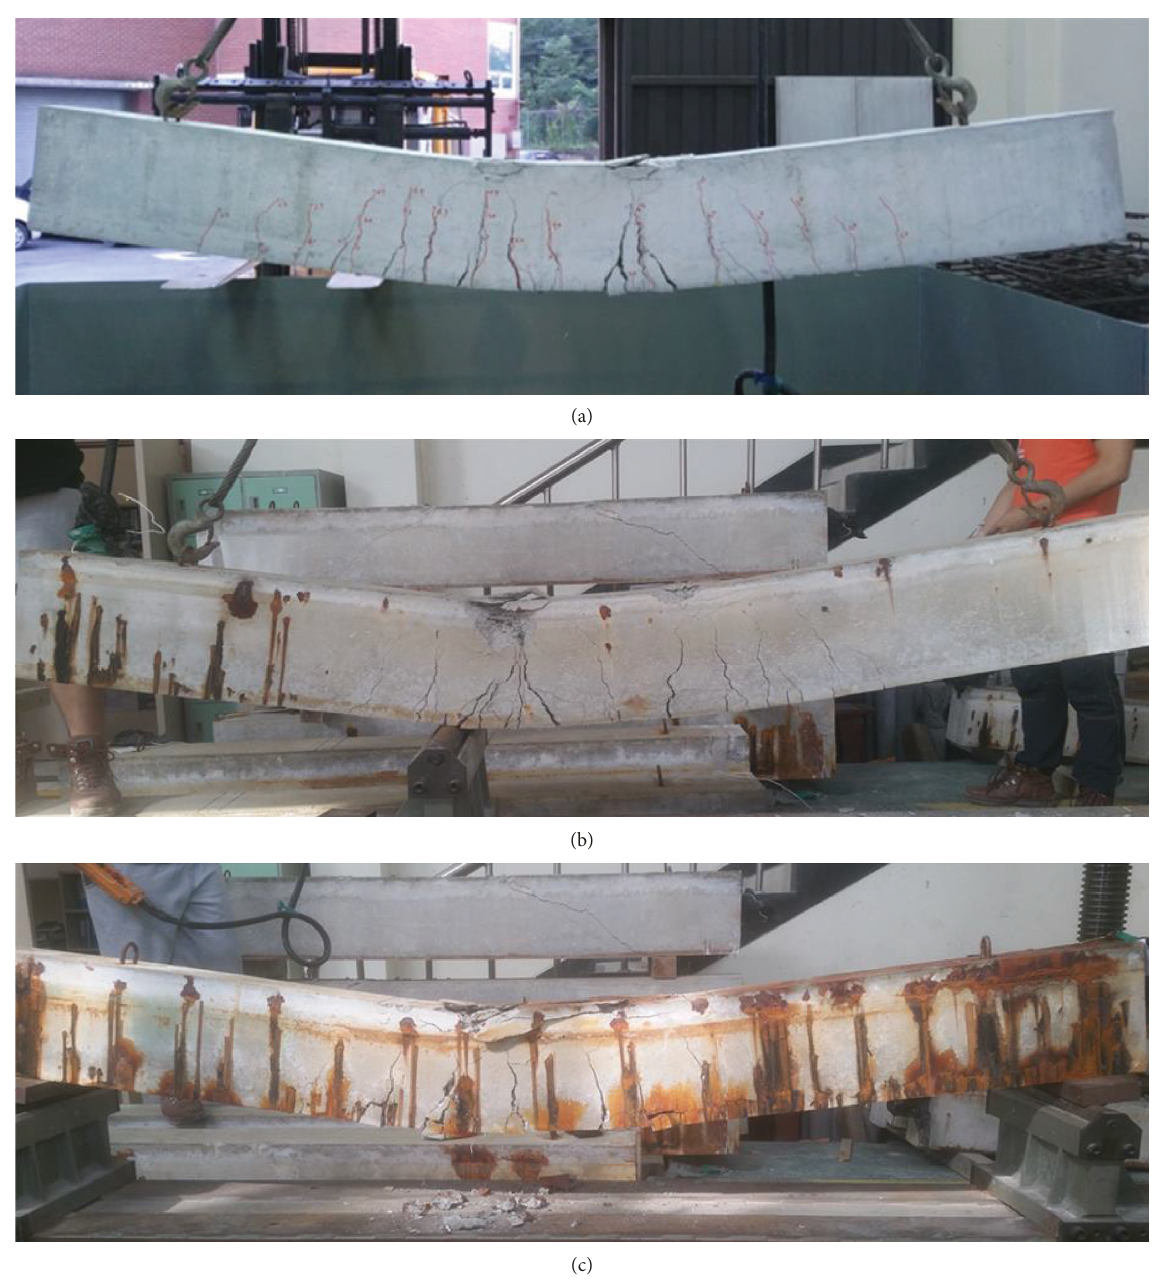
Figure 10: Cracking and failure patterns of flexural failure type beams: (a) FB-C0 beam, (b) FB-C4 beam, and (c) FB-C7